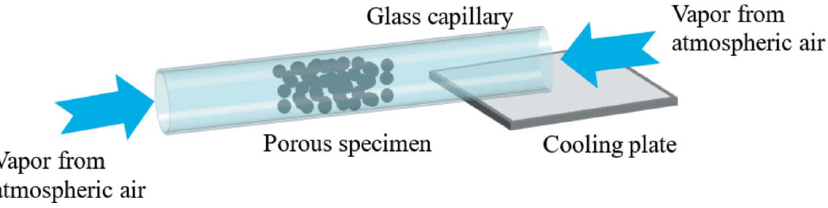
Figure 2 Schematic diagram of the condensation process of a simulated MPL. The length of the glass capillary was about 10 mm, and both ends of the glass capillary were